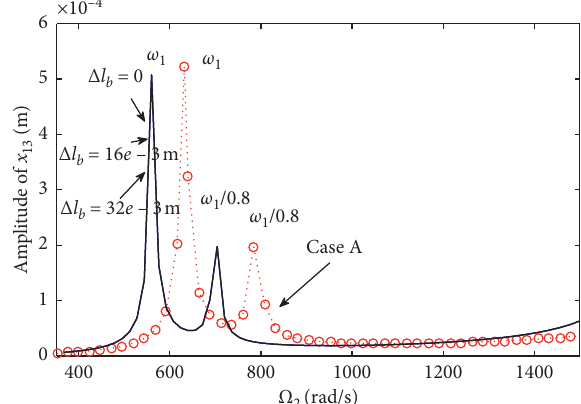
Figure 7: Vibration amplitudes of node 2 versus rotation speeds for different Δ l b .